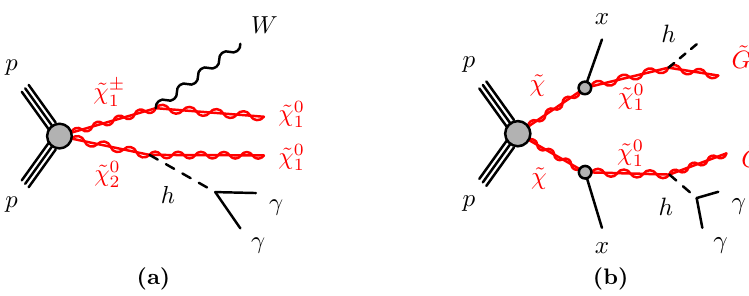
Figure 1 . Signal diagrams illustrating (a) ~ (cid:31) (cid:6) ~ (cid:31) 0 production, and (b) a higgsino production mode 1 2 ! h ~ G . For ~ (cid:31) (cid:6) from a GMSB model: ~ (cid:31) 0 ~ (cid:31) 0 production, the lightest chargino (~ (cid:31) (cid:6) 1 1 2 to-lightest neutralino (~ (cid:31) 0 ) are nearly mass degenerate. In the higgsino models, the two lightest 2 neutralinos, ~ (cid:31) 0 and ~ (cid:31) 0 , and the lightest chargino ~ (cid:31) (cid:6) are approximately mass degenerate, and the 1 2 1 ~ (cid:31) 0 is the lightest of the four nearly degenerate higgsino states, x is the particle with low momentum 1 from the promptly decay of ~ (cid:31) (cid:6) and ~ (cid:31) 0 1 2